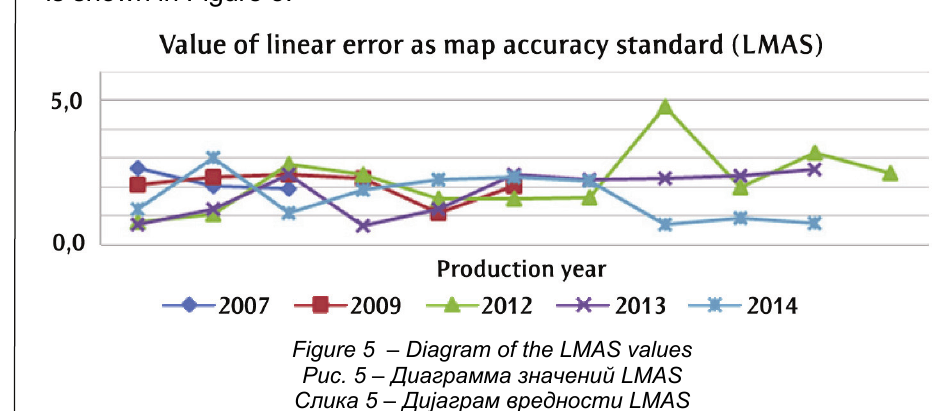
Figure 5 – Diagram of the LMAS values Рис . 5 – Диаграмма значений LMAS Слика 5 – Дијаграм вредности